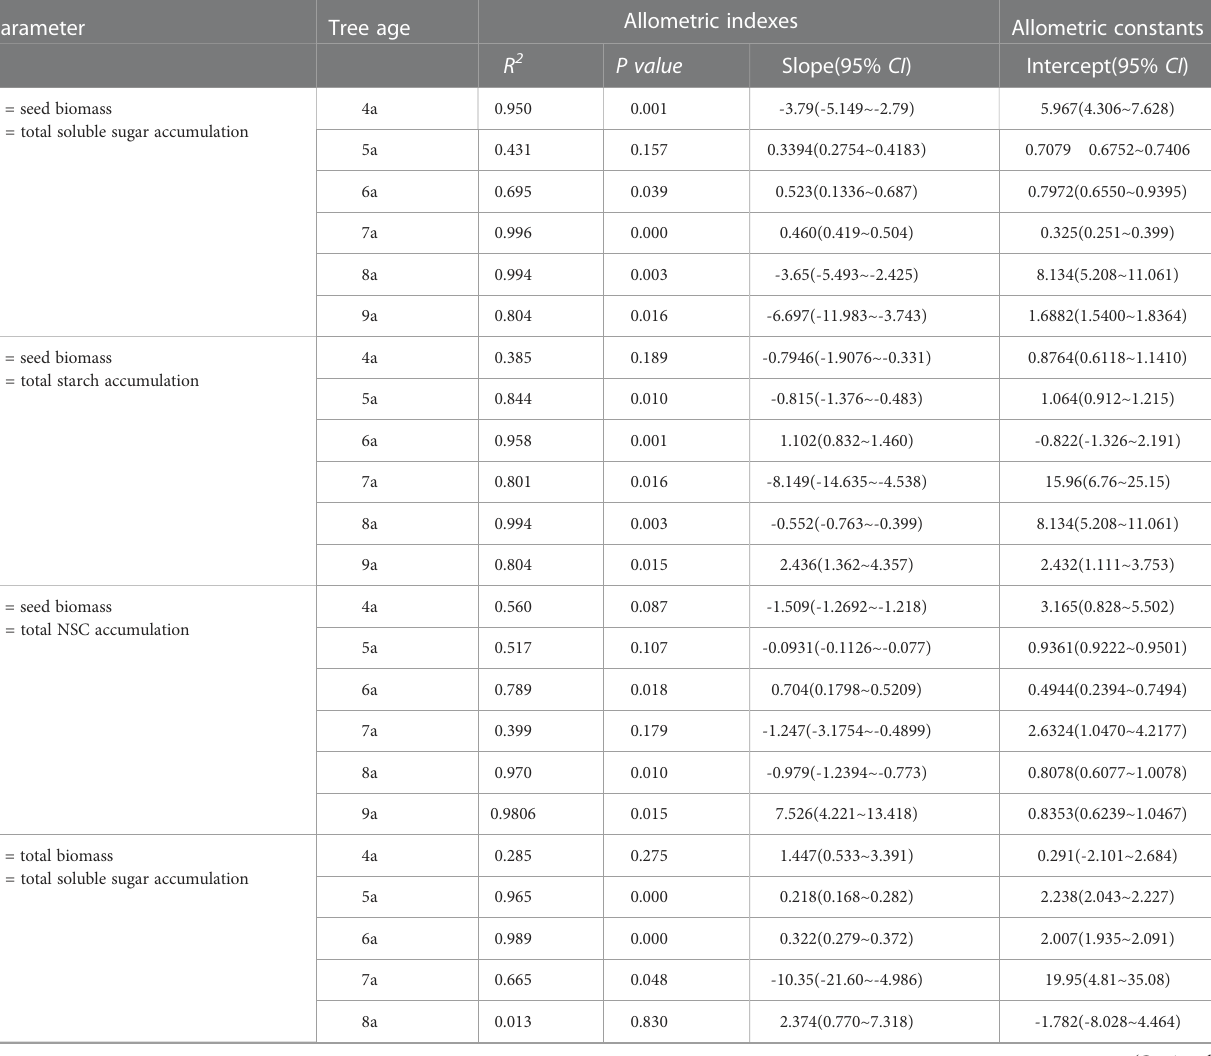
TABLE 6 The allometric growth relationship between seed biomass and total biomass and NSC accumulation of each organ and whole-plant of Fengdan during fruit ripening.